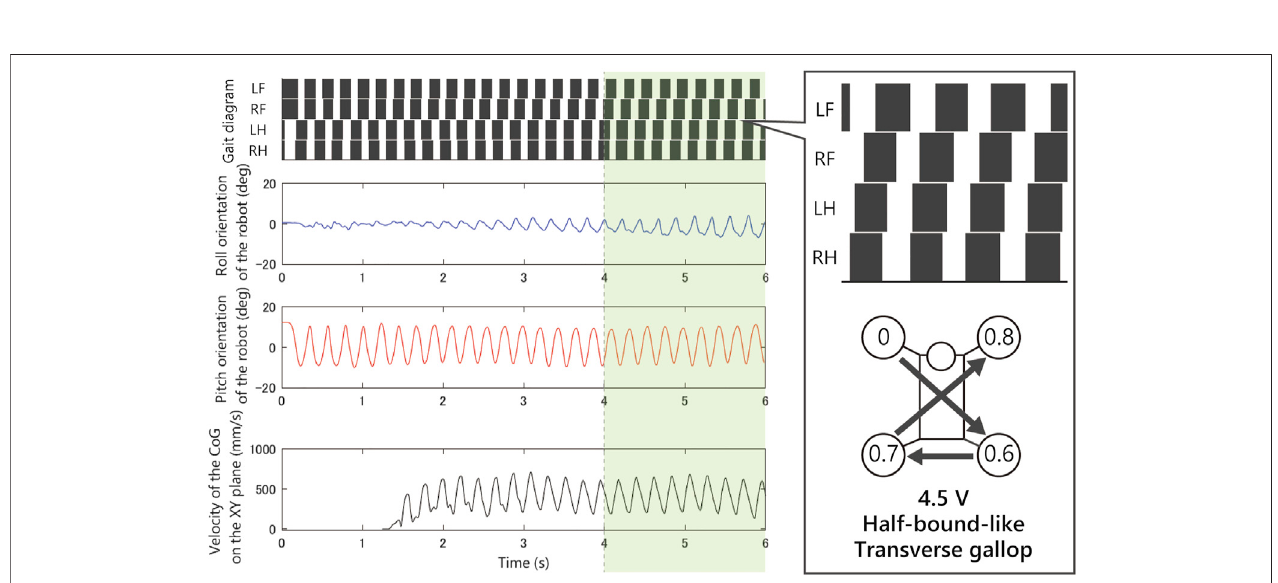
FIGURE 12 | Experimental result with an input voltage of 4.5 V. From the top: gait of the quadruped robot, roll, and pitch orientation. All the trials from the initial values converged to this half-bound-like transverse gallop gait.